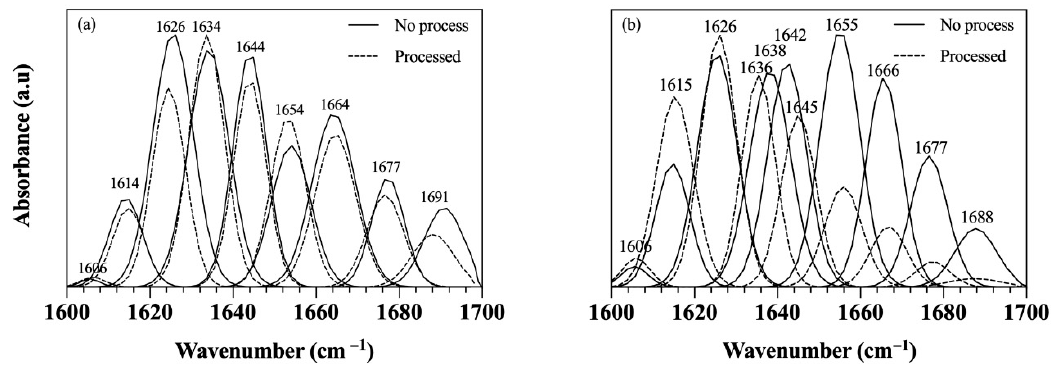
Figure 3. FTIR spectra of: ( a ) CD made with 5% whey protein ( w / w ) and ( b ) CE made with 5% whey protein ( w / w ), prior to and post the OC and HOC processing. Straight and dotted lines show the FTIR spectra of the samples before and after processing, respectively.